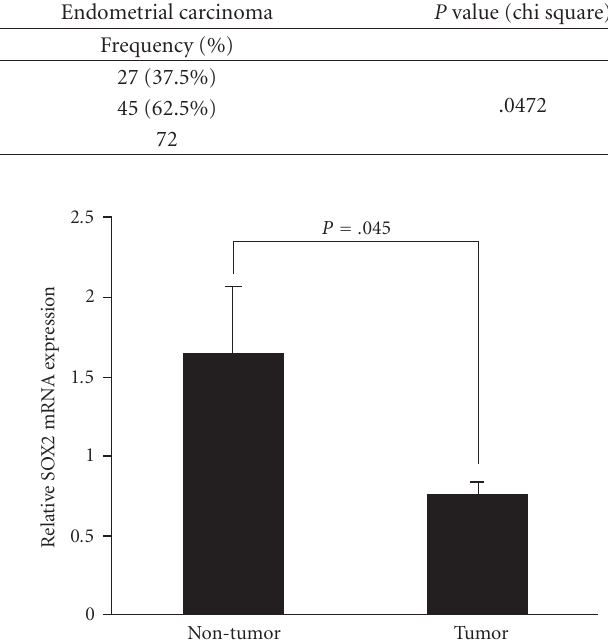
Figure 2: Relative SOX2 expression in endometrial carcinomas and in normal endometrial